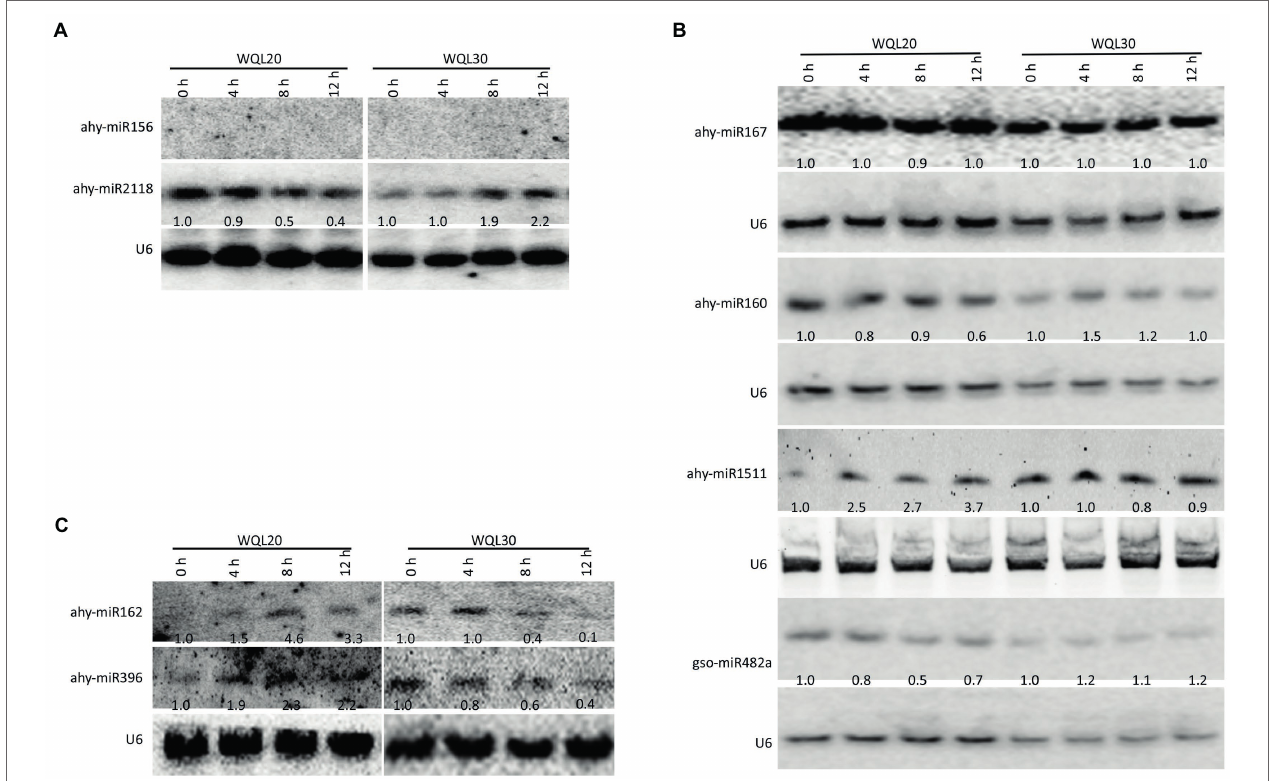
FIGURE 3 | Expression patterns of miRNAs upon low-temperature treatment. Four-leaf stage seedlings were treated with low temperature (6 ° C), and total RNA was extracted from leaves at the indicated time points. Detection of the peanut miRNAs using Northern blotting. A total of 100 μ g of total RNA was loaded. RNA blots were hybridized with DNA oligonucleotide probes complementary to the indicated miRNAs. U6 was used as a loading control. Values below each section represent the relative abundance of miRNA normalized to